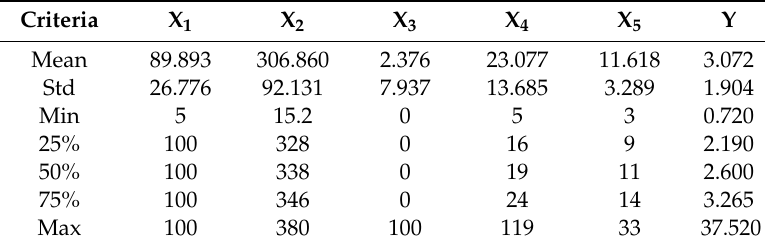
Table 2. Statistical Measures of Dataset Features.